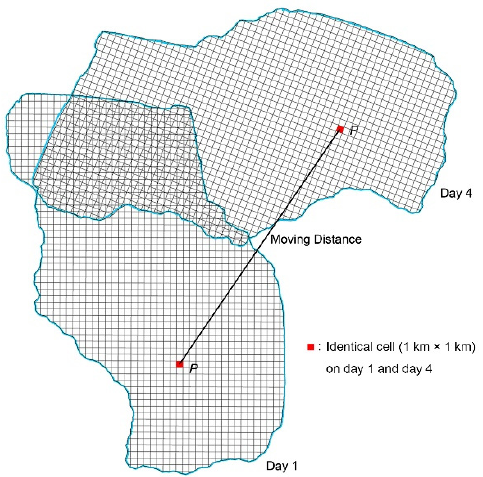
Figure 3. Diagram for calculating the speed of different parts of the iceberg.